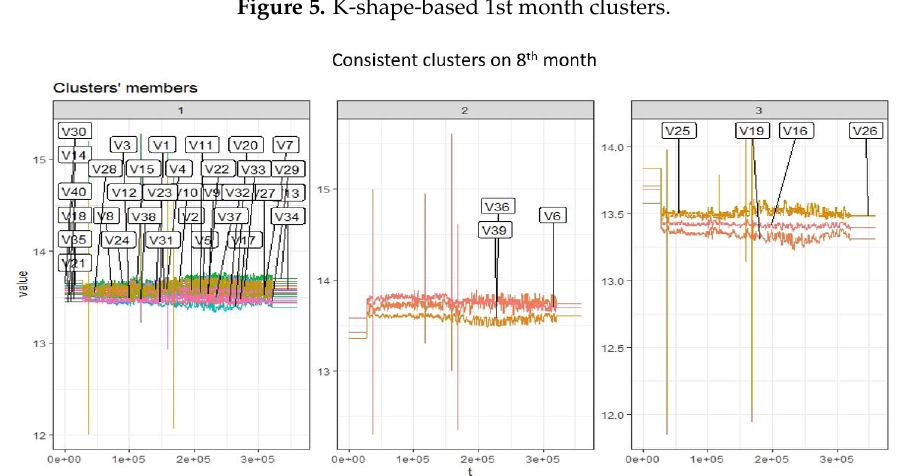
Figure 6. Consistent clusters after eight months.